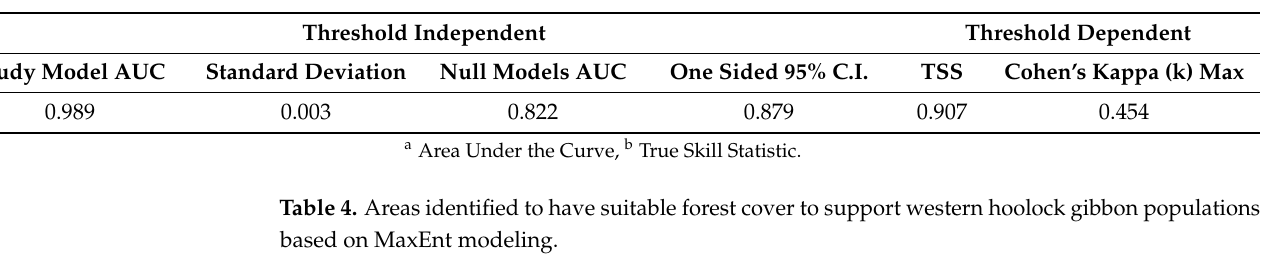
Table 3. Mean AUC a values of the species model and null models, TSS b and Kappa values for Hoolock hoolock distribution in Bangladesh.